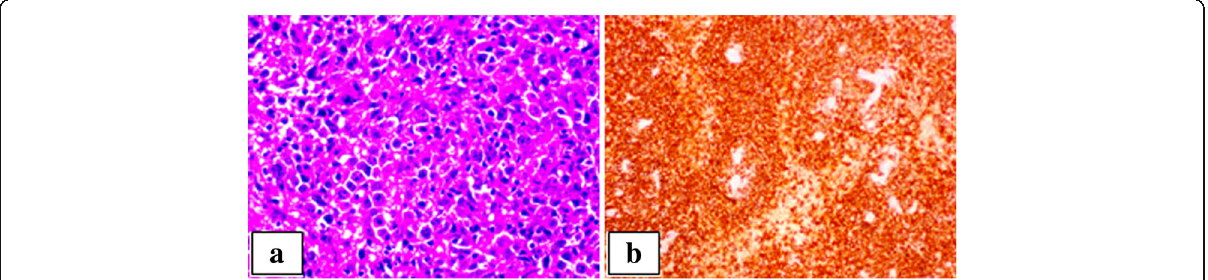
Fig. 4 a Photomicrograph showing large round to oval cells present in sheets with a high nuclear/cytoplasmic ratio, H&E × 40. b IHC showing CD20